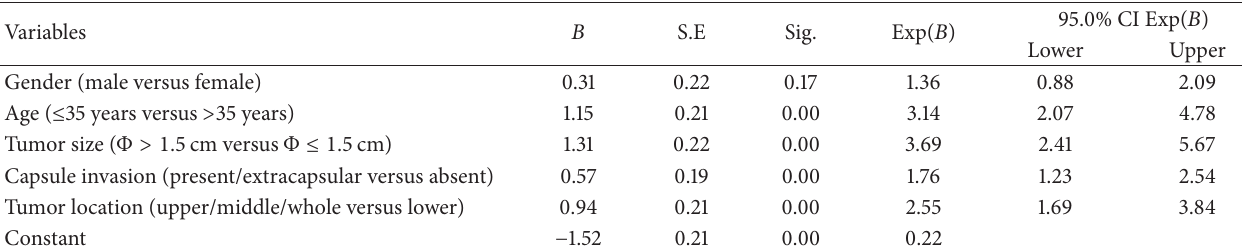
Table 6: Multivariate logistic regression for CLN